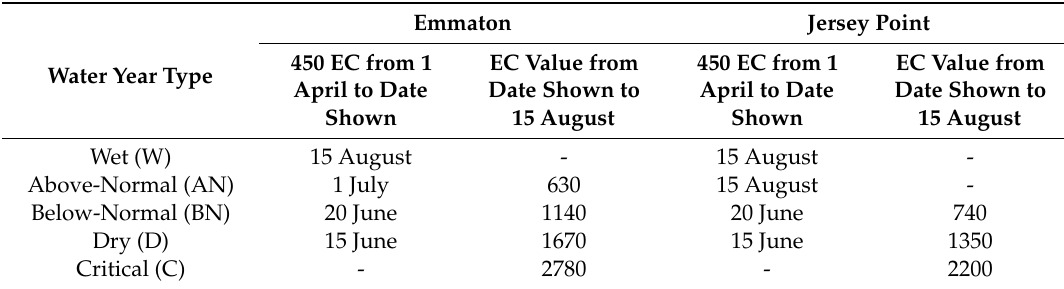
Figure A3. Exceedance probability curves of reference and simulated (via MBSG, MLP4, LSTM4, and the hybrid model) ( a ) salinity and ( b ) high range only salinity during the evaluation period from water year 2003 to 2014. Table A1. The maximum14 day running average of mean daily salinity (EC, µs/cm) at Emmaton and Jersey Point in different types of water year [20].